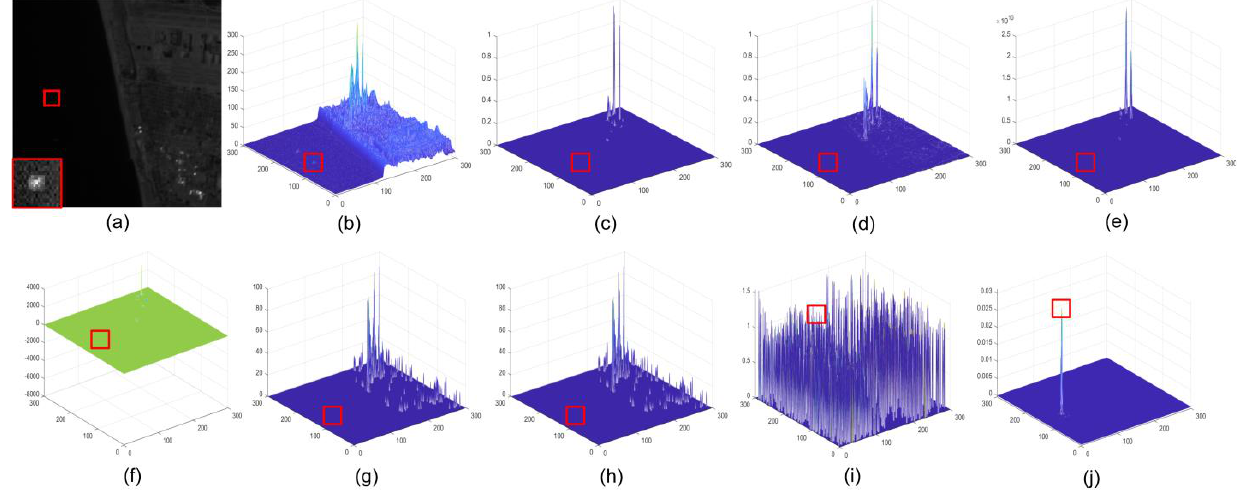
Figure 6. Detection results of different methods in Seq.1. The positions of aerial targets are highlighted by the red rectangles; ( a ) raw image, the details of target are magnified at the left bottom corner; ( b ) three-view of raw image; ( c ) result of STLCM; ( d ) result of STLCF; ( e ) result of FSM; ( f ) result of NSM; ( g ) result of STJP; ( h ) result of DNGM; ( i ) result of MLTC; ( j ) result of LSM.